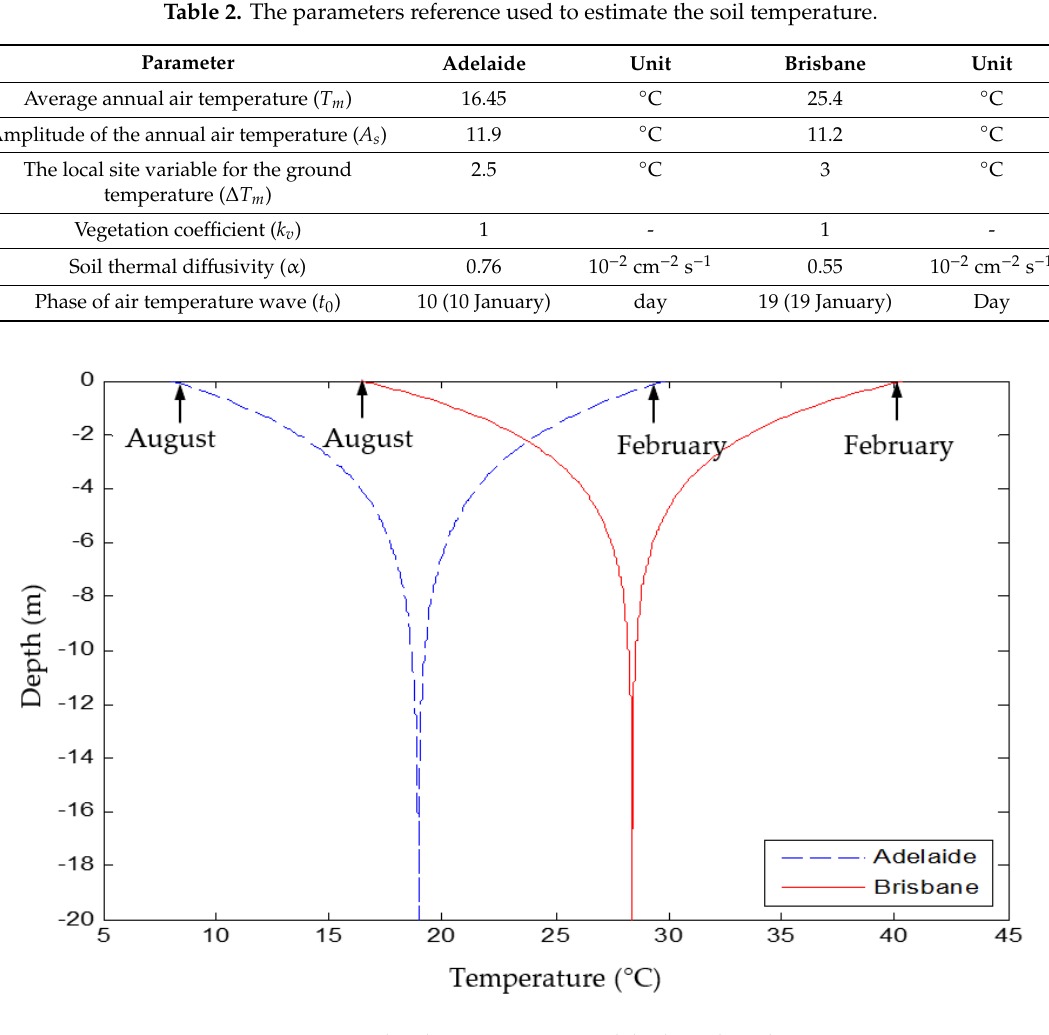
Figure 6. An example of ambient temperature in Adelaide and Brisbane on 3 consecutive summer days. The effect of seasonal changes on the soil temperature is modelled by incorporating the internal source term concept into the GHE model [21]. The value of the internal source term varied with the soil depths. It was higher in a shallow region and lower in a deeper zone. At a depth of 12 m below the ground surface, the value of the internal source term was assumed to be zero (this corresponded to the depth at which the effect of the ambient temperature on the soil temperature was negligible).